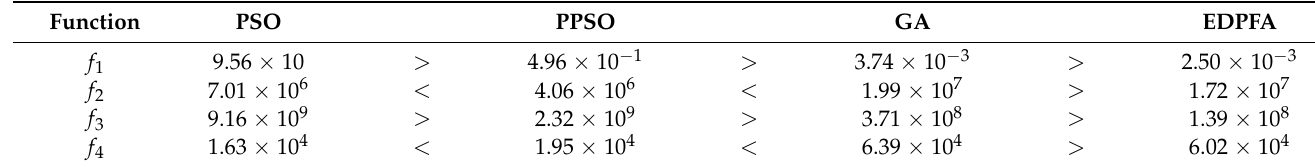
Table 5. Comparison of the EDPFA with some common algorithms.